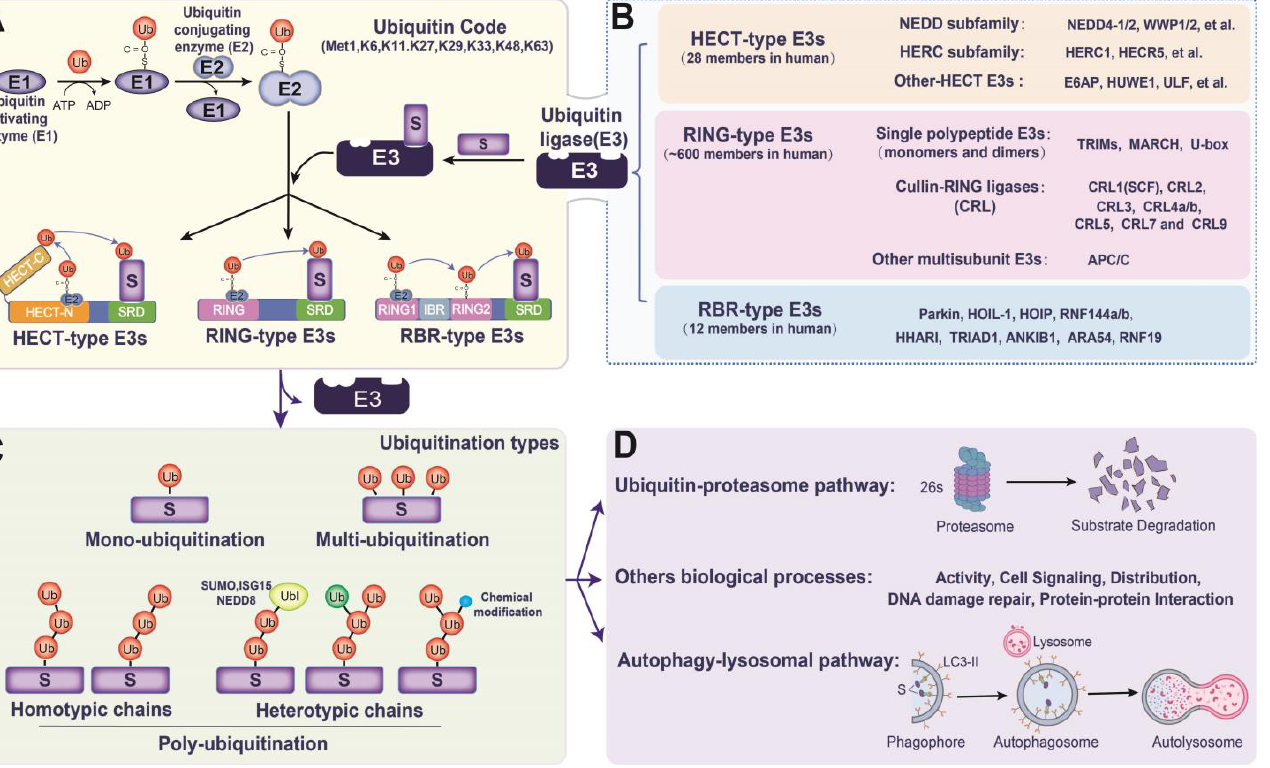
Figure 1. The types and functions of the E3s family: ( A , B ) the process of ubiquitin being activated and translocated to a substrate via E1, E2, and E3s (the E3s family is divided into three types (HECT-type, RING-type, and RBR-type E3s), depending on how ubiquitin is transferred from E2 to substrate proteins); ( C ) E3s catalyze substrates to undergo monoubiquitylation, multiubiquitylation or polyubiquitylation; ( D ) ubiquitinated substrates activate proteins, participate in cell signaling, repair DNA damage and distribute and degrade proteins via the ubiquitin-proteasome pathway (UPP) or autophagy-lysosome pathway (ALP). Abbreviations: S , substrate for ubiquitylation; Ub, ubiquitin; HECT, homologous to E6-AP carboxyl terminus; RBR, RING-between-RING; IBR, in-between RING; RING2: RING or Rcat; SRD, substrate-recognizing domain.